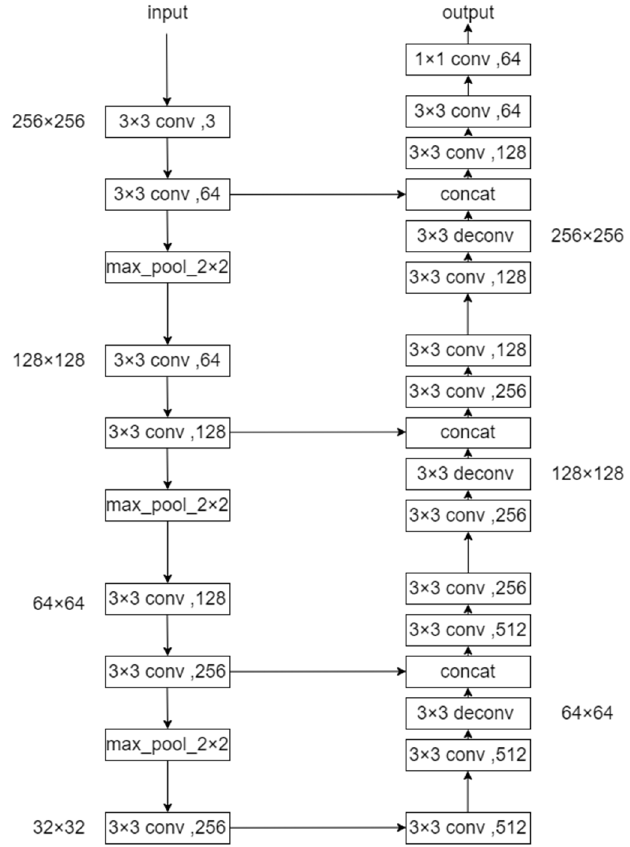
Figure 5. The network structure of UNet.